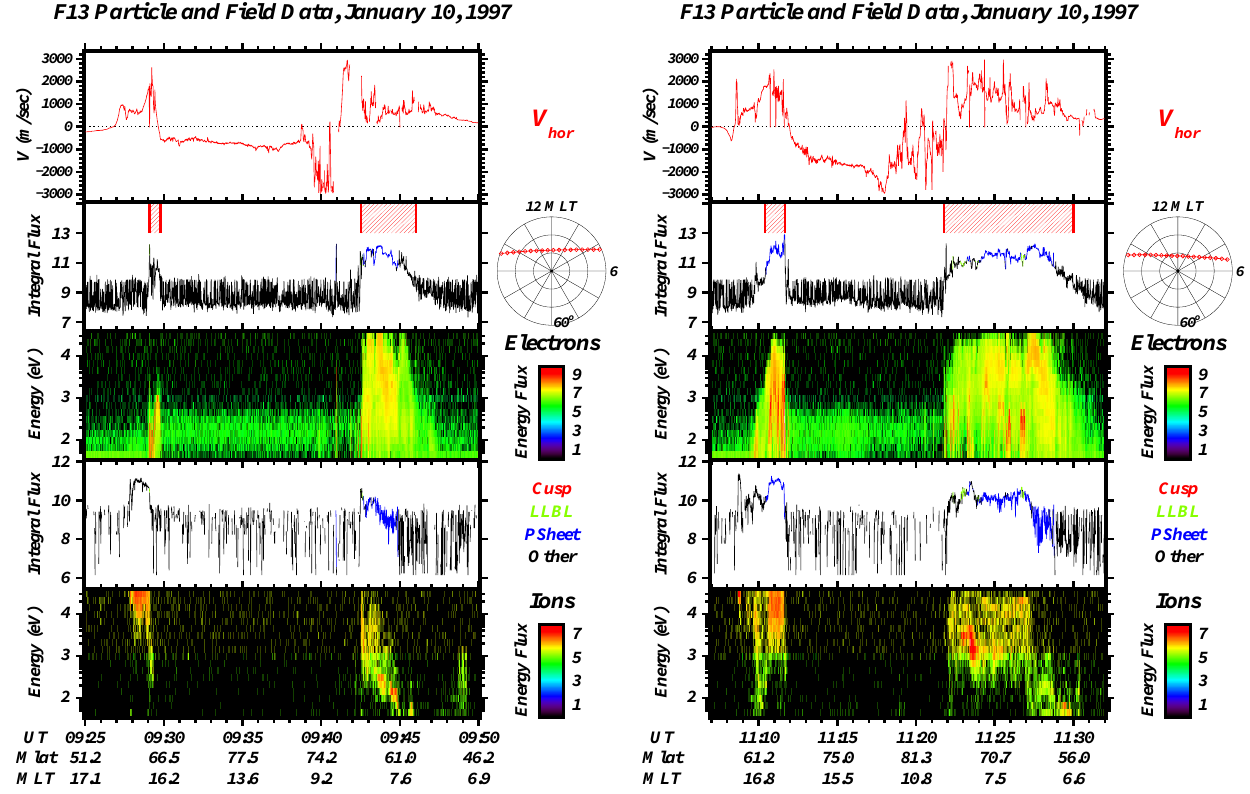
Fig. 10. DMSP F13 particle and electric field data for 10 January 1997, before (left) and after (right) the pressure pulse event. Each plot shows (from top to bottom) horizontal ionospheric velocity, electron integral energy flux, electron differential energy flux, ion integral energy flux, ion differential energy flux. The spacecraft orbit is shown in the inset to the right of the electron integral energy flux. The red hatched boxes above the electron integral flux curves denote the oval locations as determined in Fig. 1. The ionospheric velocity is measured perpendicular to the spacecraft orbit, in this case almost along the day-night direction, sunward when positive and antisunward when negative. Dramatically enhanced flows all along the satellite path are seen in the “after”